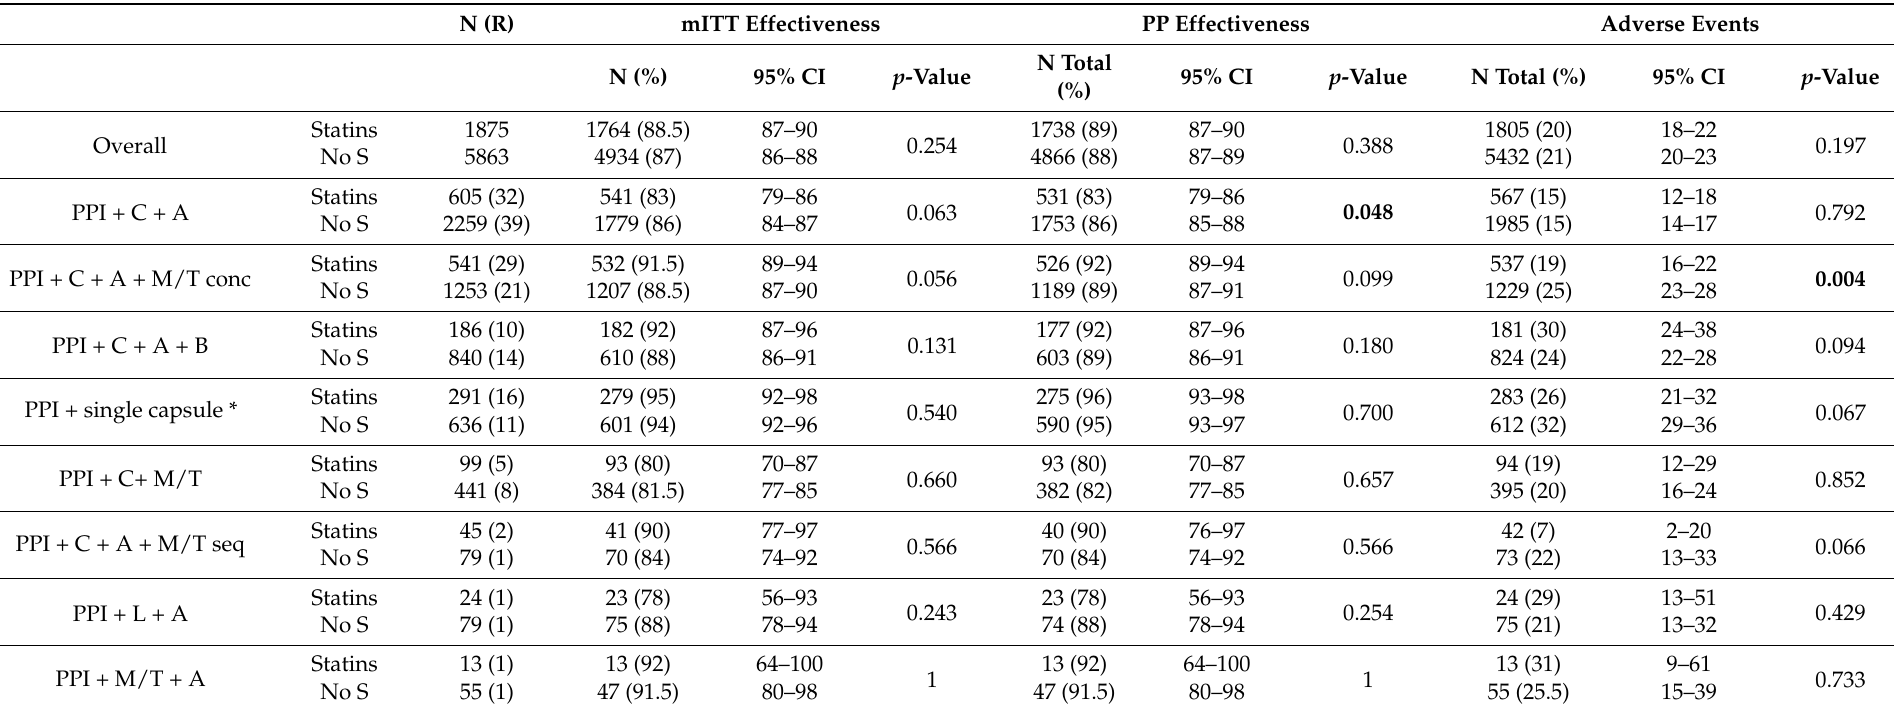
Table 5. Effectiveness and safety in first-line empirically prescribed